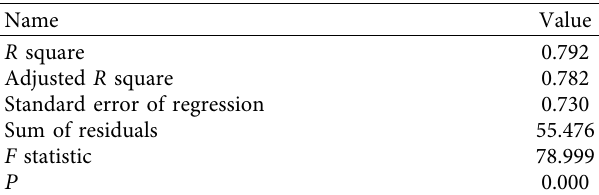
Table 3: Statistics of the quadratic model (acceleration peaks